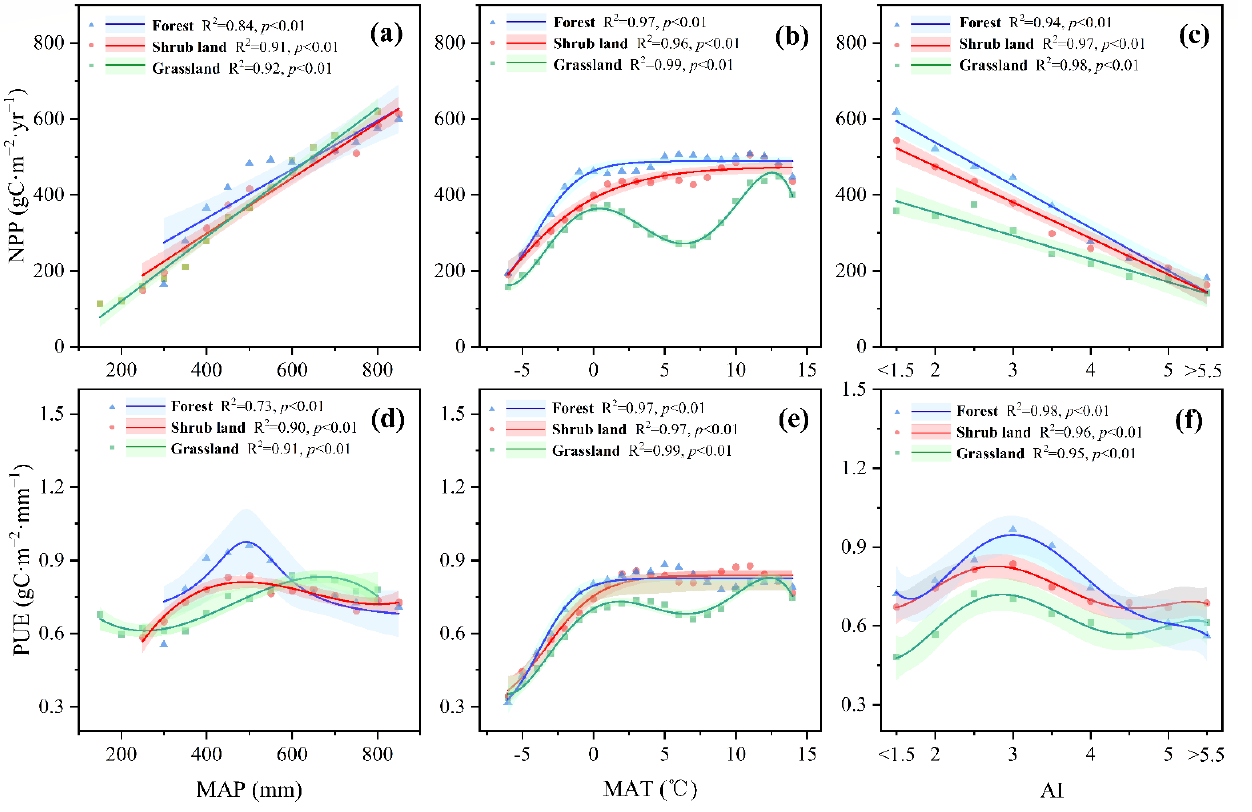
Figure 5. Variations in NPP and PUE across the map ( a , d ), MAT ( b , e ), and AI ( c , f ) gradient of the forest, shrub land, and grassland in the YRB. Lines were the regression curves, and shading represented the regression analysis confidence range (5th and 95th percentiles). Each point was the averaged value at 50 mm MAP intervals in ( a , d ), 1 ◦ C MAT intervals in ( b , e ), and 0.5-unit AI intervals in ( c , f ).